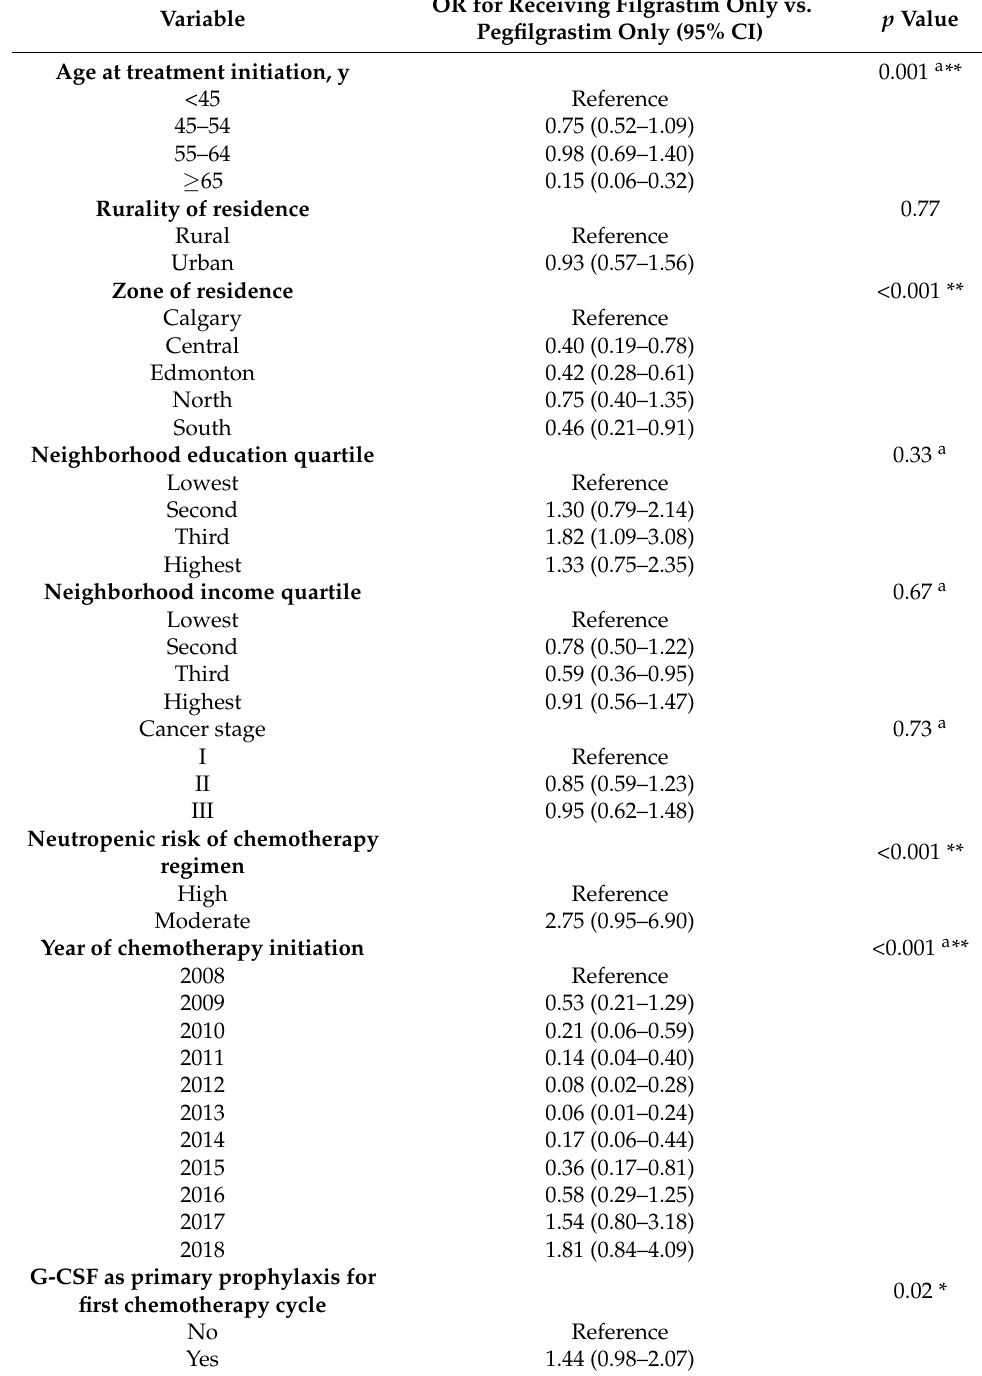
Table 4. Multivariable logistic regression analysis of predictors of filgrastim use among patients who received either filgrastim or